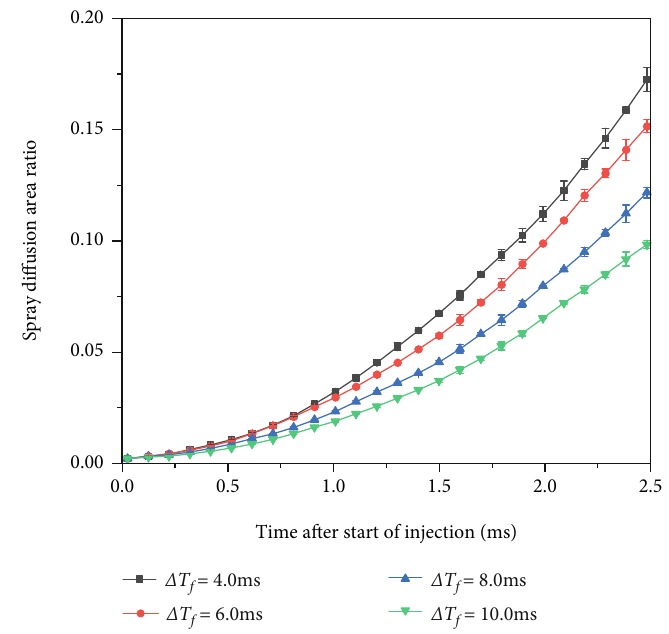
= 0 : 8 MPa , T = 298 K f f